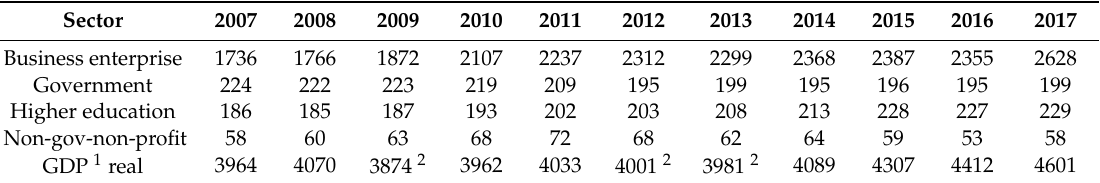
Table 1. Numbers of Research and Development (R&D) subjects in the Czech Republic in sectors 2007–2017